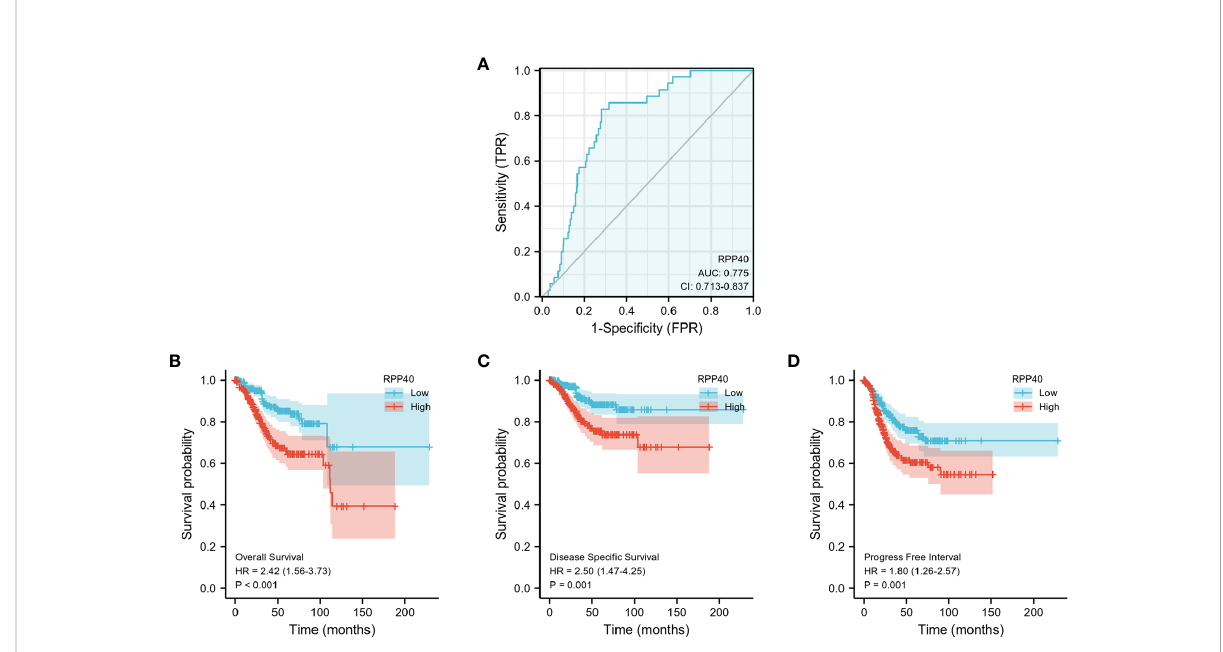
FIGURE 4 Predictive value of RPP40 expression for diagnosis and survival in UCEC patients. (A) ROC curve analysis was used to evaluate the performance of RPP40 for UCEC diagnosis. (B-D) K-M analyses were used to compare OS (B) , DSS (C) , and PFI (D) between high- and low-RPP40- expression groups of UCEC patients.